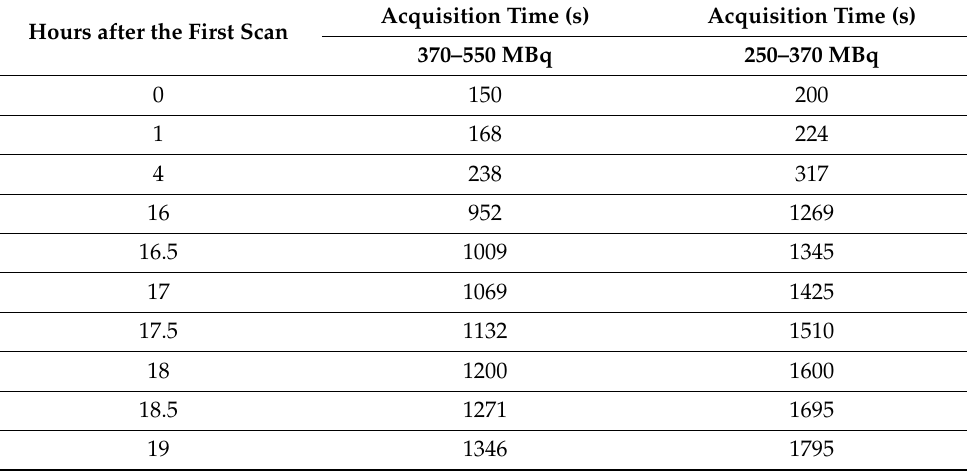
Table 1. Acquisition time correction for [99m]Tc